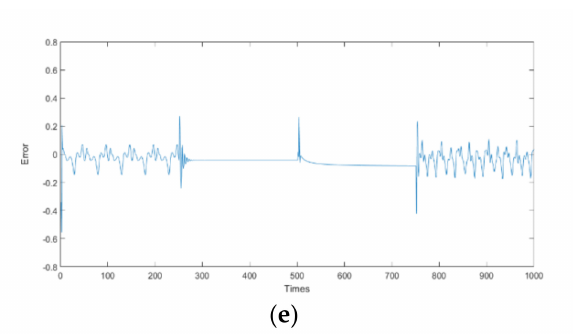
Figure 11. Dynamic system identification error rates of ( a ) DGCPSO, ( b ) DE [24], ( c ) PSO [25], ( d ) QPSO [26], and ( e ) CPSO [27].